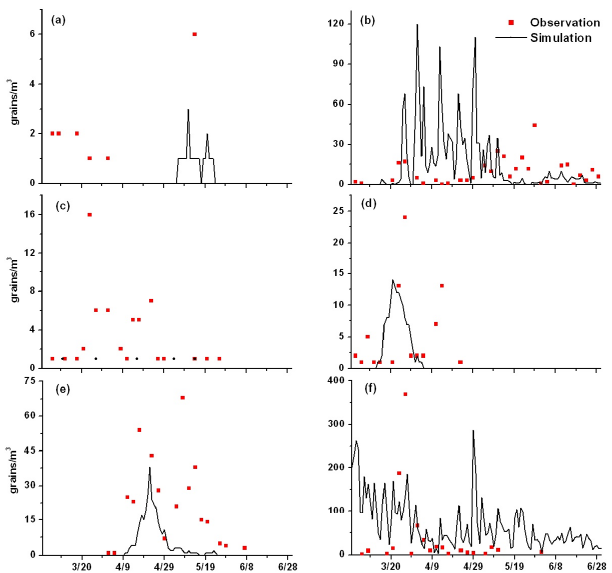
Fig. 8. Time series of simulated pollen concentrations at the Caltech site (CALT) during March–June 2010 for (a) birch, (b) grass, (c) walnut, (d) mulberry, (e) olive, and (f) oak.